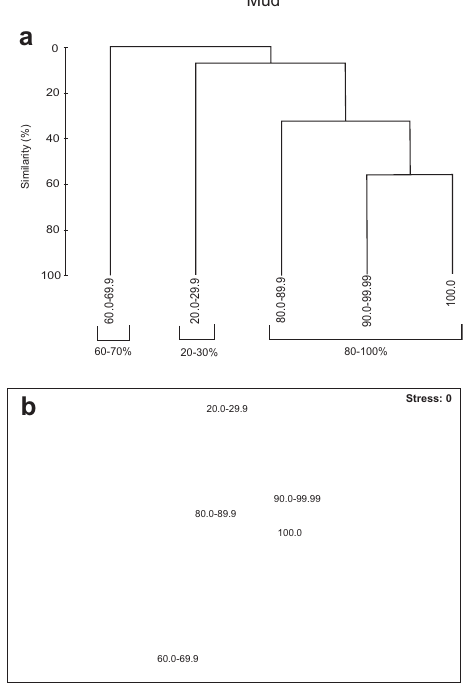
F IG . 6. – Percentage of mud ranges (grouped to the nearest 10%), according to polychaete densities. a) Dendrogram (Bray-Curtis sim- ilarity index; group average link); b) non-metric multi-dimensional scaling